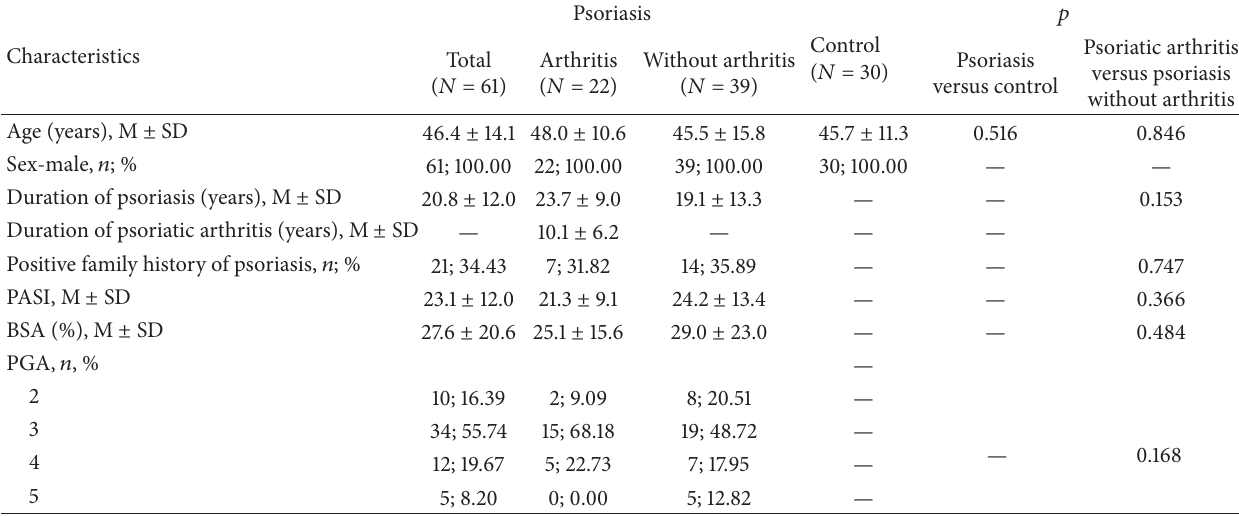
Table 1: Sociodemographic characteristics and clinical data of psoriasis patients and control